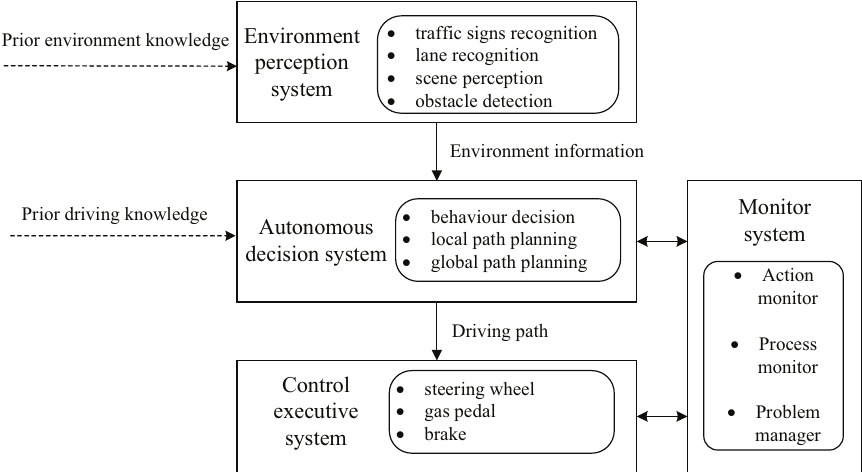
Figure 3. The overall technical framework of self-driving cars with a Level3 or higher autonomy